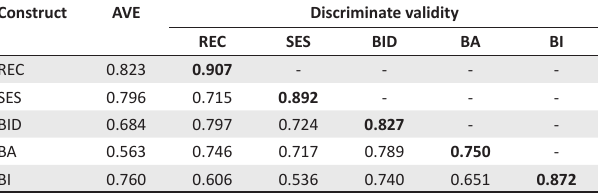
TABLE 2: Correlation coefficient matrix and the square roots of average variances extracted. Construct